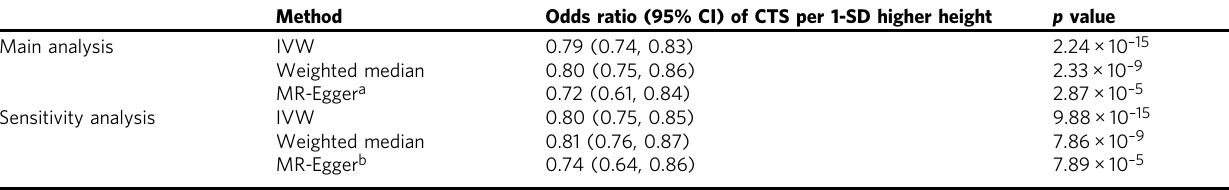
Table 3 Mendelian randomisation study of height and CTS